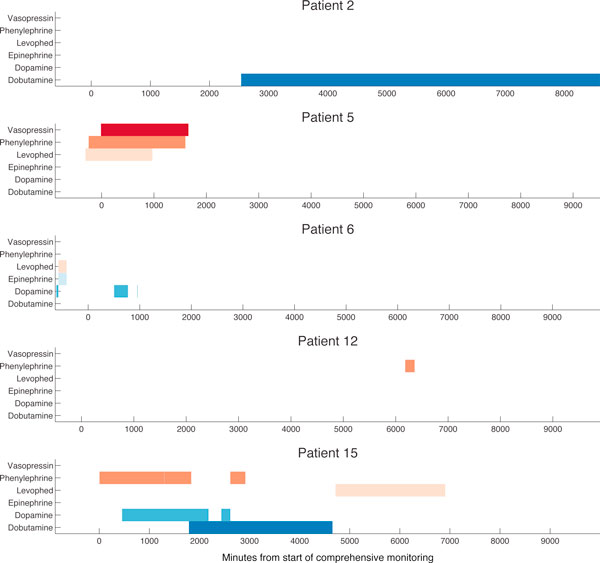
Timing and drug specification for the five patients who received pressors. The x-axis shows the entire time (in minutes) for which we obtained comprehensive physiological data with time zero being the start of microdialysis catheter placement.